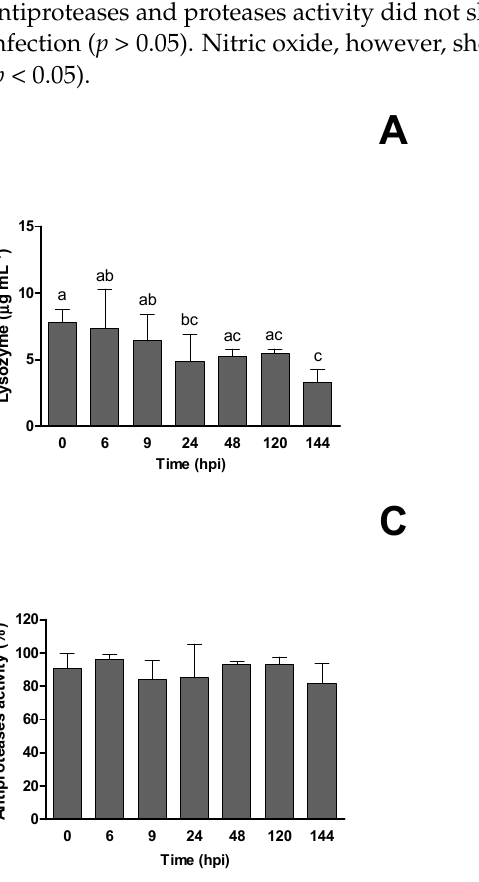
E Figure 2. Cont